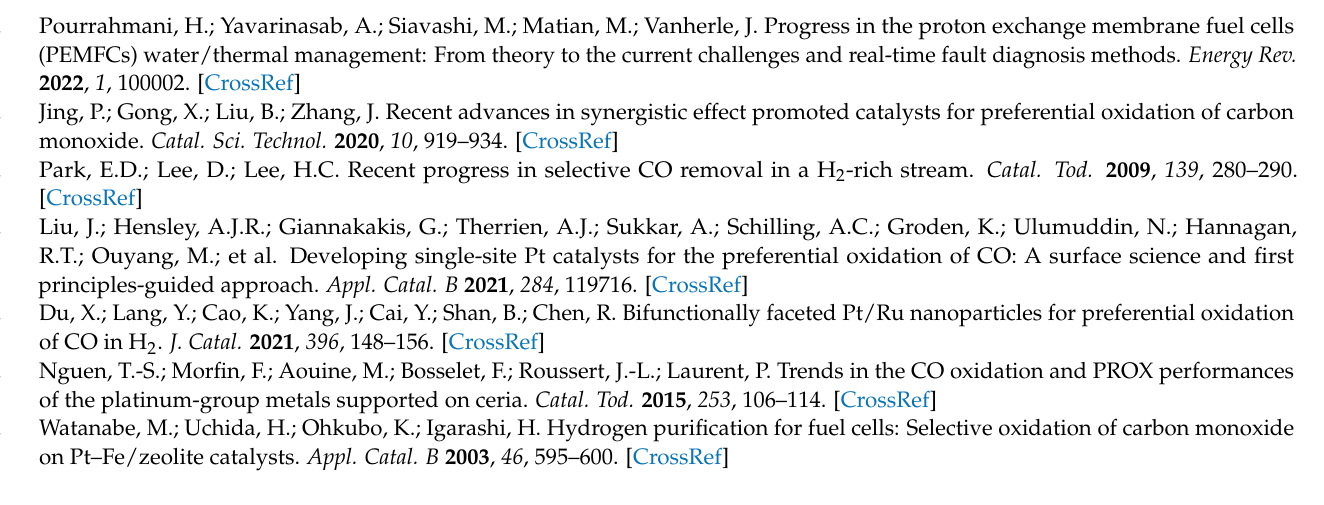
15; Figure S3: TEM images (a, b) of 0.05Pt/Z-28 and (c, d) of 4.5Co/Z-28; Figure S4: (a) TEM image and EDX element distribution maps of (b) Si, (c) Co and (d) Pt of 0.01Pt/4.5Co/Z-15; Figure S5: (a) TEM image and (b) particle size distribution of 0.01Pt/4.5Co/Z-15; Figure S6: (a) TEM image and